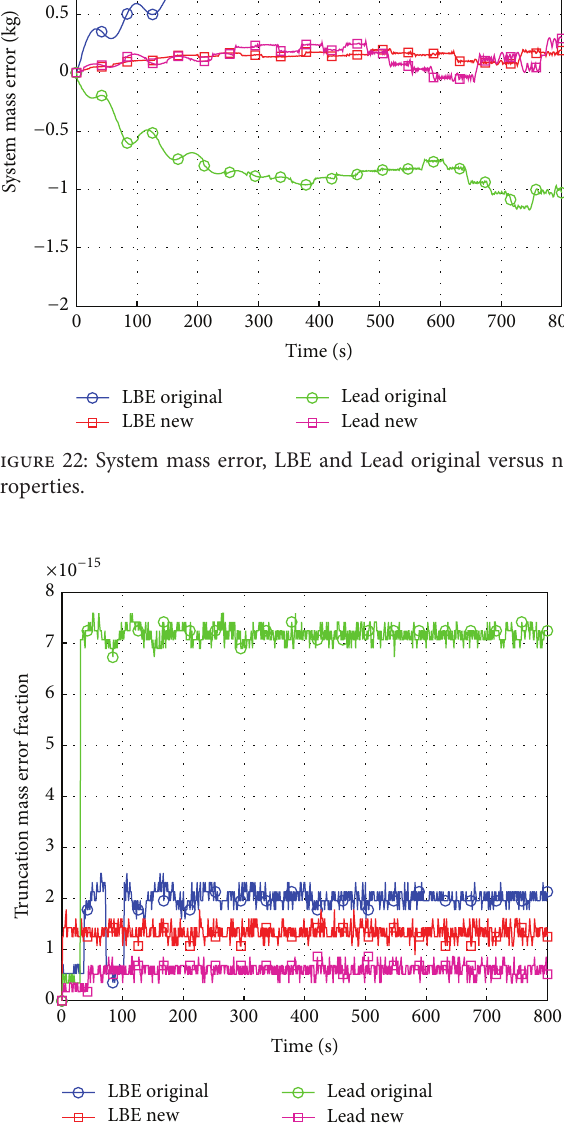
Figure 23: System truncation error, LBE and Lead original versus new properties.